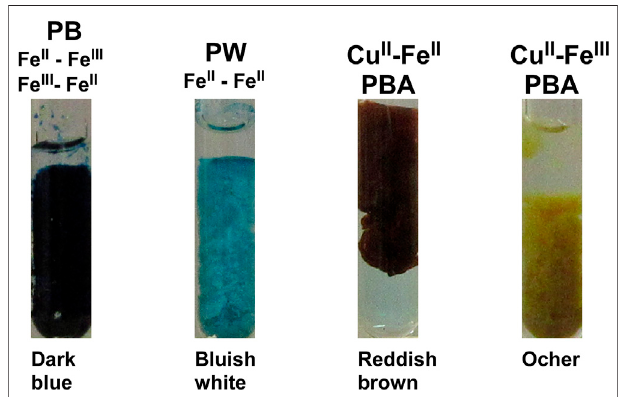
FIGURE 2 | Precipitates of PB, PW, and Cu ‒ Fe PBA formed at 25 ° C in aqueous solutions. The types of precipitates are indicated at the top. The colors of these precipitates are labeled at the